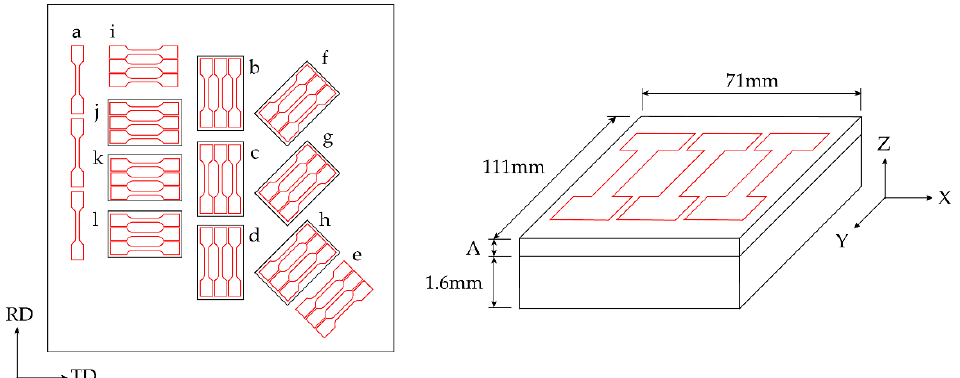
Figure 3. LMD pad locations (internal black boxes) on sheet with the tensile test specimen extraction locations (red) indicated, and tensile gauge lengths in-line with pad length (Y).